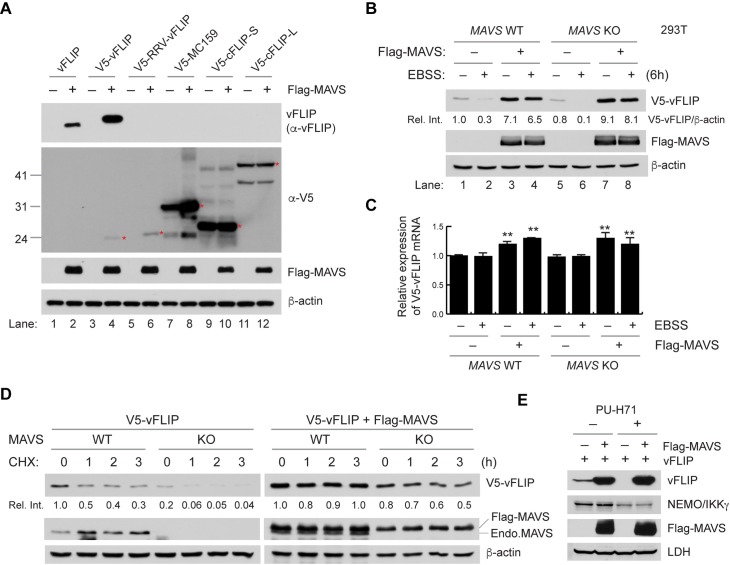
MAVS selectively stabilizes vFLIP.(A) Immunoblots of extracts of 293T cells transfected with non- or V5-tagged viral and cellular FLIPs along with empty or Flag-MAVS vectors for 24 h. Red asterisks indicate bands of expected molecular weight. (B) Immunoblots of extracts from WT and MAVS KO 293T cells transfected with V5-vFLIP and either empty vector or Flag-MAVS and incubated in EBSS and complete media (–EBSS) for 6 h. Relative V5-vFLIP intensities normalized to β-actin were noted under each band. (C) Real time-quantitative PCR analysis of V5-vFLIP mRNA expression. Total RNAs were isolated from the cells transfected and treated as in (B) above. Data are represented as mean ± SD of triplicate samples. (**p<0.05) (D) Immunoblots of extracts from WT and MAVS KO 293T cells transfected with V5-vFLIP and either empty vector or Flag-MAVS and treated with cycloheximide (CHX) for 0, 1, 2, and 3 h. “Endo.MAVS” indicates endogenous MAVS. (E) Immunoblots of extracts from 293T cells transfected with vFLIP and either empty vector or Flag-MAVS and treated with DMSO or 1 μM PU-H71 for 24 h.